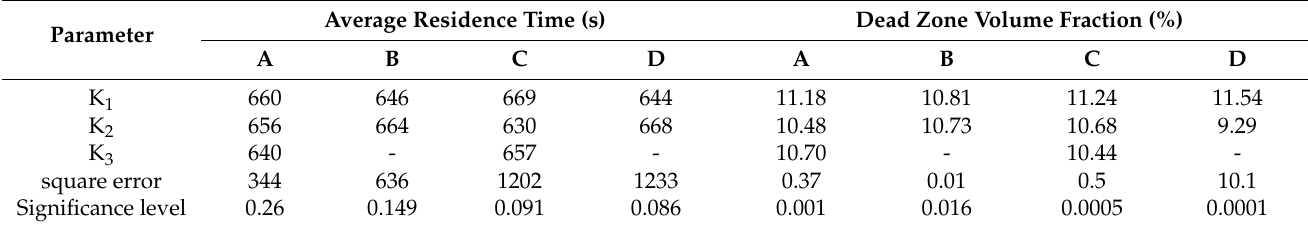
Table 4. Range of average residence time and dead zone volume fraction of different